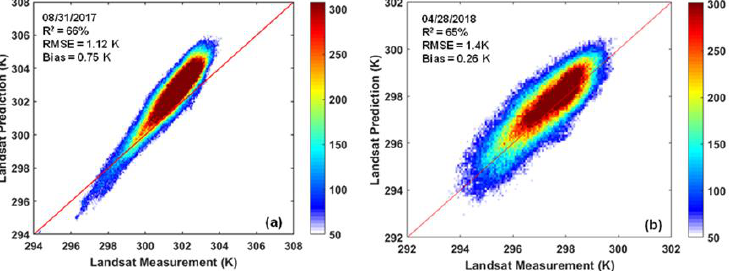
Figure 6. Density scatter plots between LST from SDM and Landsat–8 over New York City for ( a ) 31 August 2017 and ( b ) 28 April 2018. The error metrics such as coefficient of determination, root–mean–square error and bias are also provided in each plot. Table 2. Correlation coefficient and root–mean–square error (RMSE) between downscaled LST and Landsat–8 LST over New York City for three different land cover types. Correlation Coefficient RMSE (K) Tree canopy Grass/Shrub